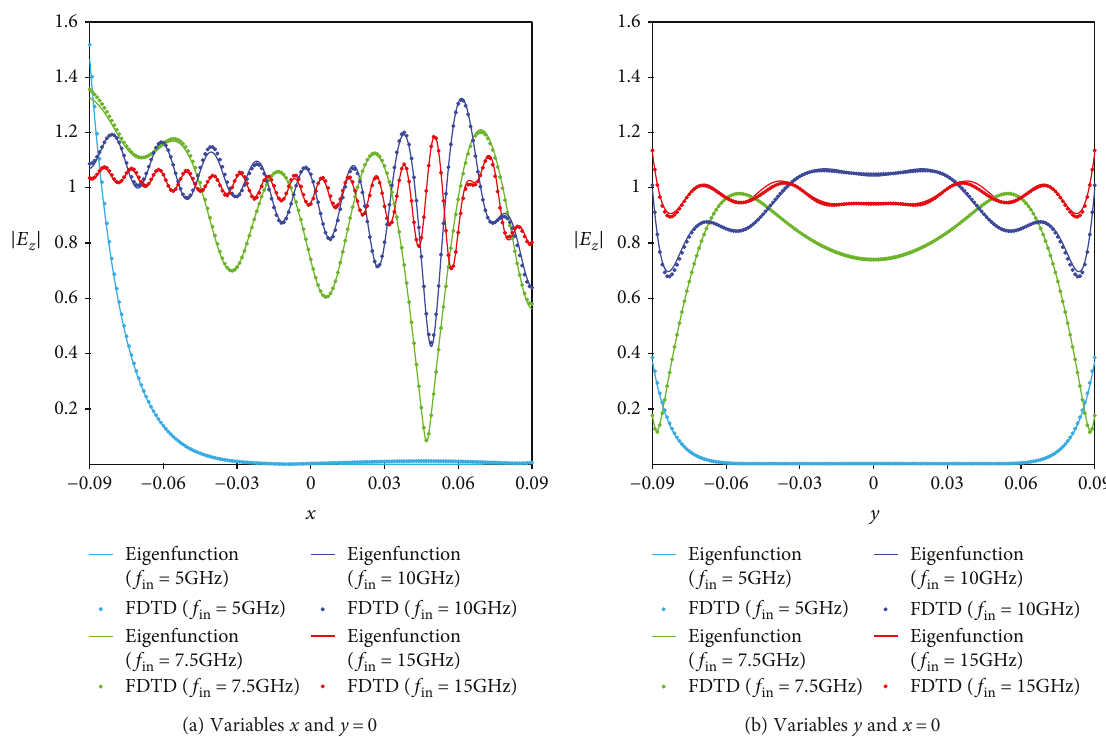
Figure 9: Comparison between the magnitude of the electric fi eld, in volts/meter, inside the plasma for linear cuts through the cylinder obtained by the eigenfunction method and the FDTD simulation for di ff erent incident frequencies; electron density is set to n =5 × 10 17 m − 3 , and electron collision frequency is set to ν =500 × 10 6 Hz. 0